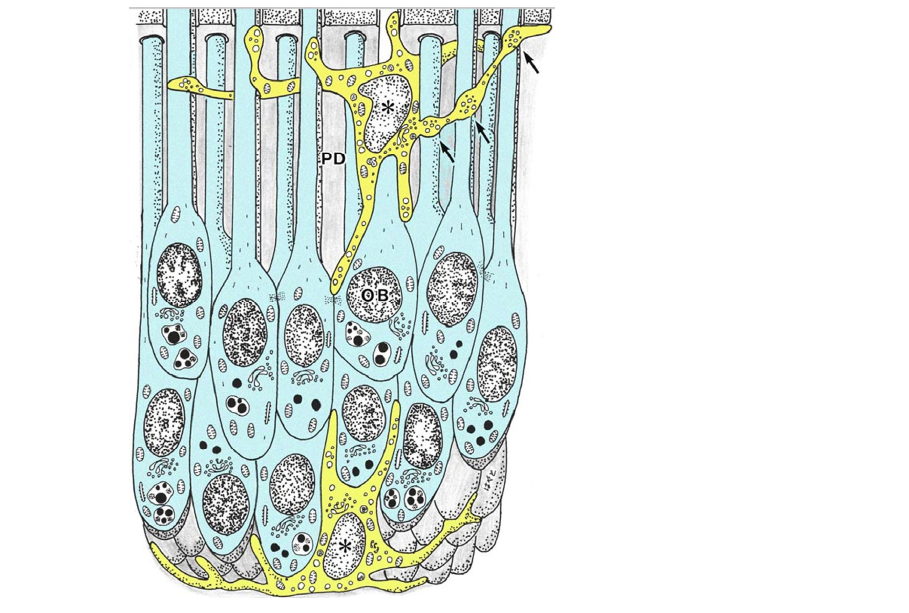
Figure 1. Schematic view of the spatial relationships between MHC + class II cells and odontoblasts (OB) in the human dental pulp (cited from Ohshima et al. [82], with permission from Springer Nature). An MHC + class II cell (asterisk) in the predentin (PD) makes contact with several odontoblast processes via cytoplasmic extensions that have a beaded appearance (arrows).